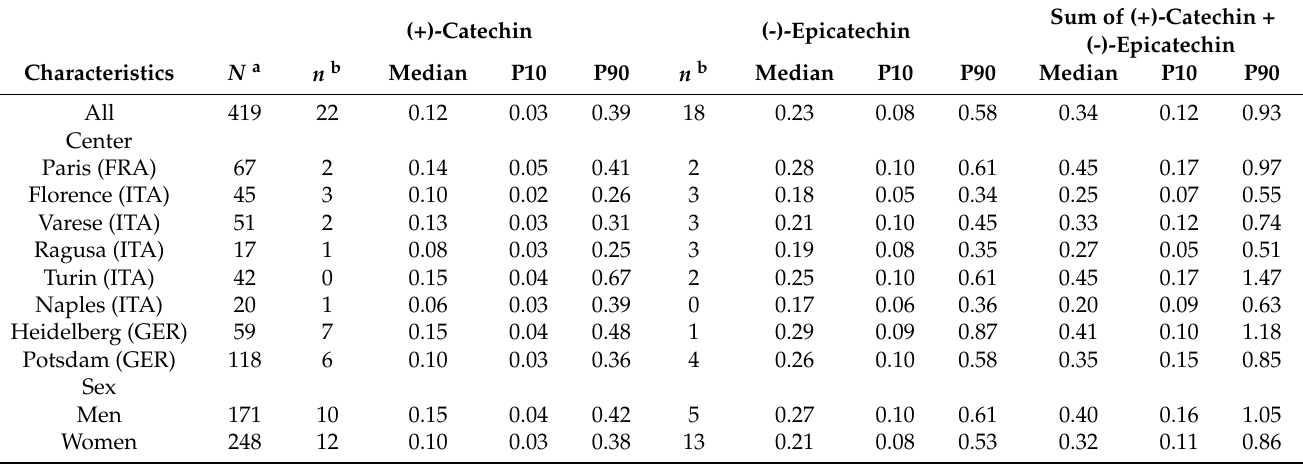
Table 1. Medians, and 10th (P10) and 90th (P90) percentiles of urinary excretion ( µ mol/24 h) of (+)-catechin, (-)-epicatechin, and their sum according to sociodemographic and lifestyle characteristics in a subsample ( n = 419) of the European Prospective Investigation into Cancer and Nutrition (EPIC)